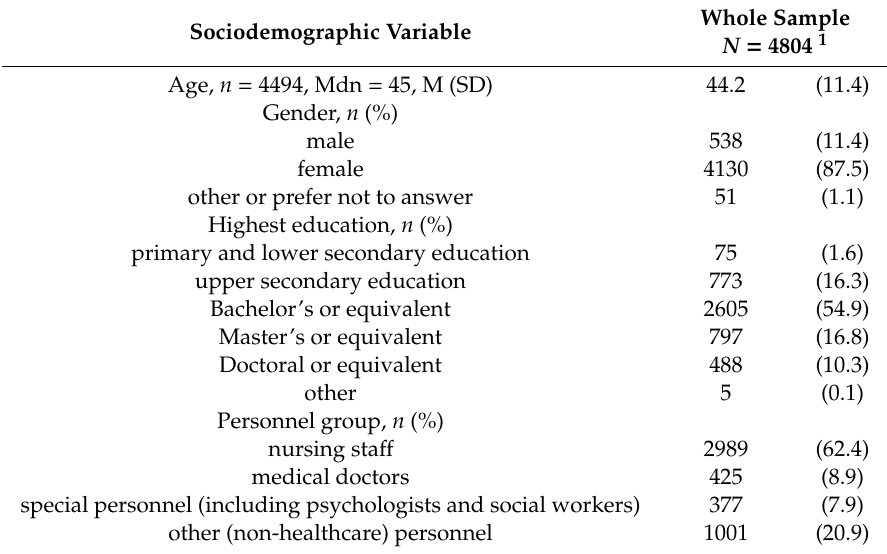
Table 1. Sociodemographic background information of the HUS personnel participants of the well-being